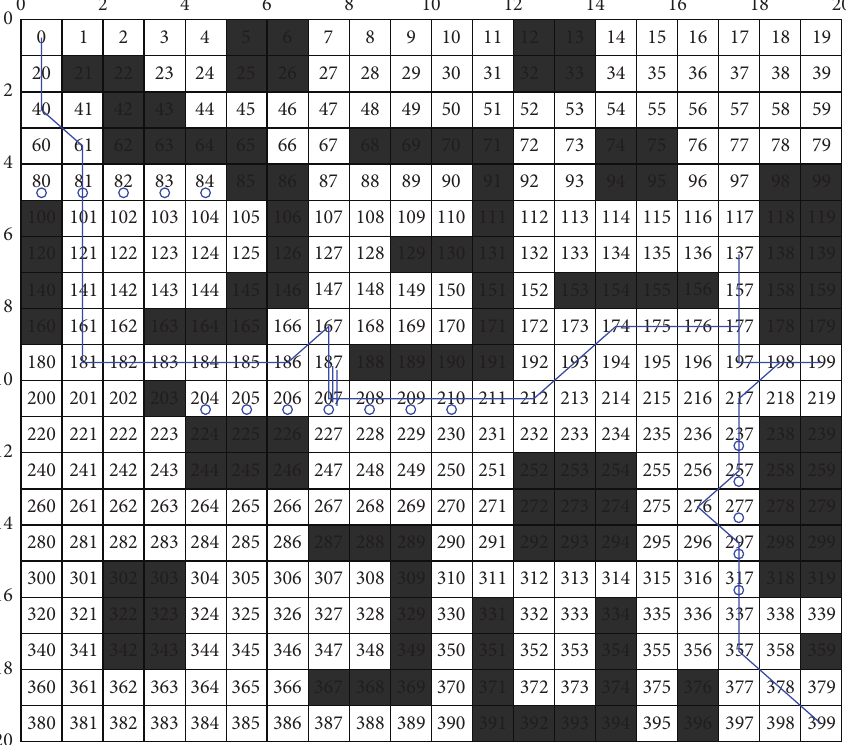
Figure 12: Arrival at the final